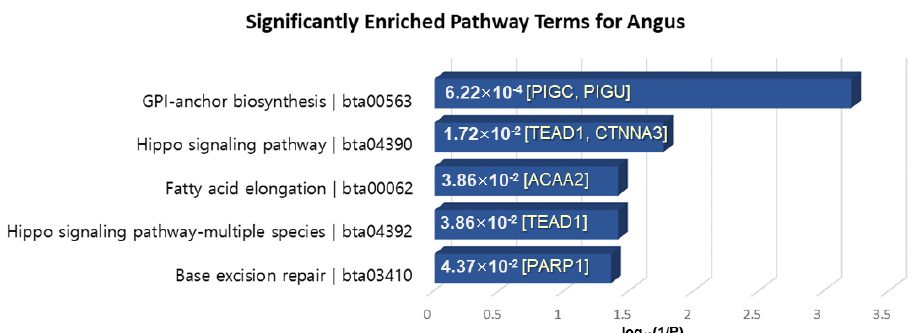
Figure 7. KEGG pathway enrichment analysis of the 40 overlapped genes in the Angus breed. The x - axis is the log10(1/ p -value), and the annotated genes of the enriched pathways with significant p - values shown in bar graphs.